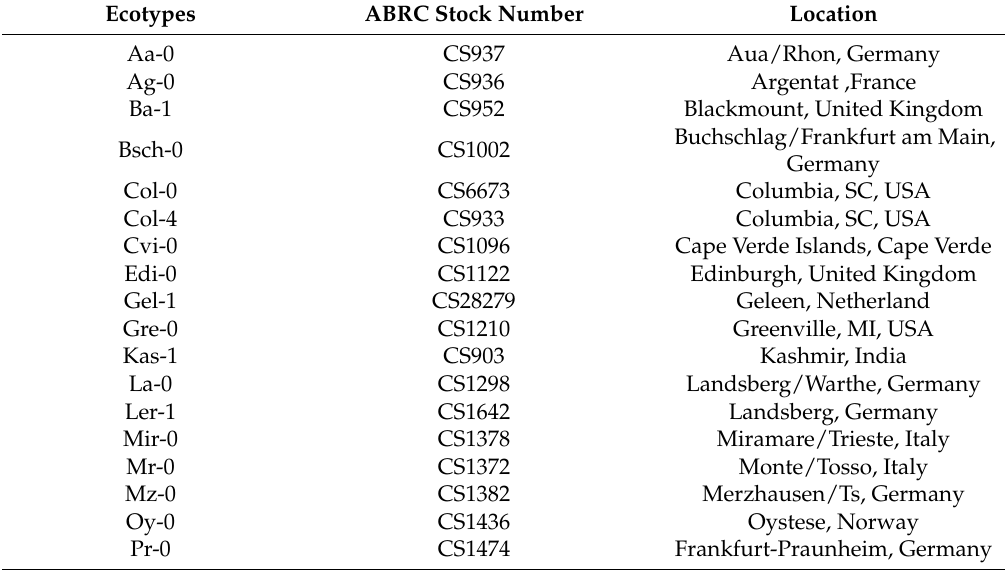
Table 4. Ecotypes used in this